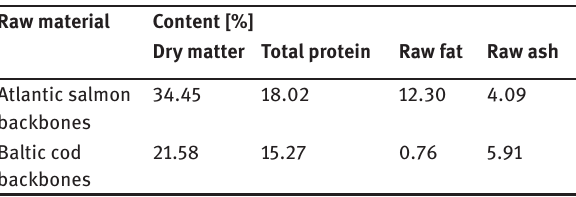
Table 2: Basic physico-chemical parameters of the fish backbones used as raw material in the processing (%).